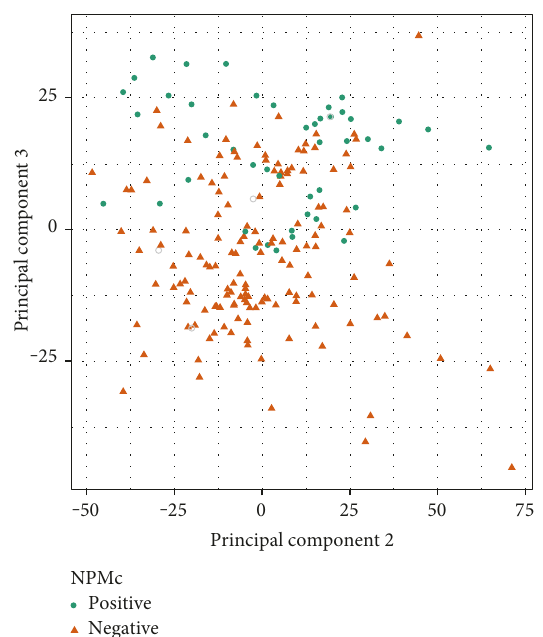
Figure 2: Low-dimensional representation of AML dataset. Scatter plot shows coordinates of NPMc traits on principal components (PC). Gray circles represent missing values. PC2 and PC3 show better separation of NPMc-positive and NPMc-negative patients (positive in upper and negative in lower) than PC1 and PC2 (not shown). PC3 is highly signi fi cant for NPMc (Wilcoxon rank sum test, p = 5 1 E − 13